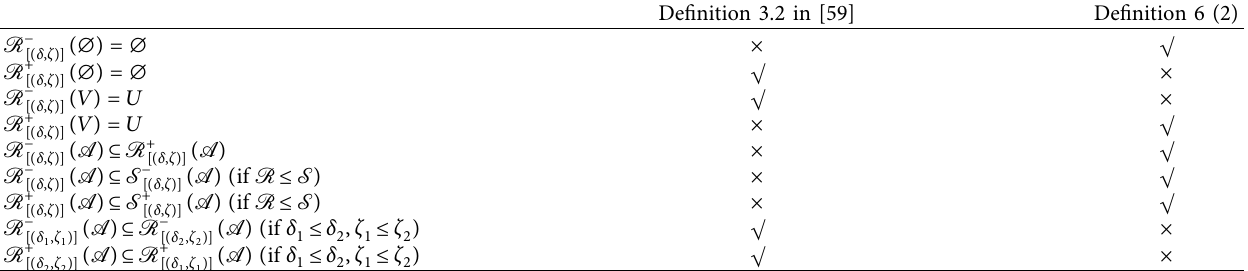
Table 2: Comparison between some properties by Definition 3.2 in [59] and 6 (2).